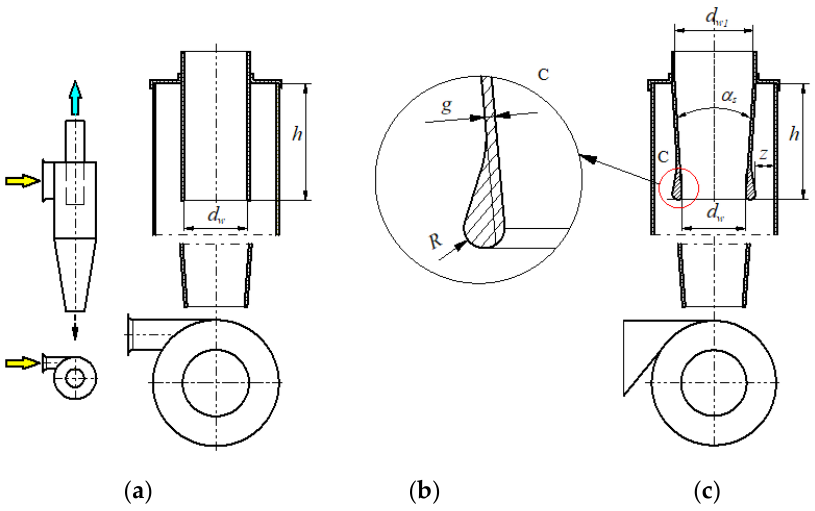
Figure 29. Modification of D -40 cyclone design—Version W3: ( a ) original cyclone version, ( b ) element C of modification and ( c ) modification A + B + C.